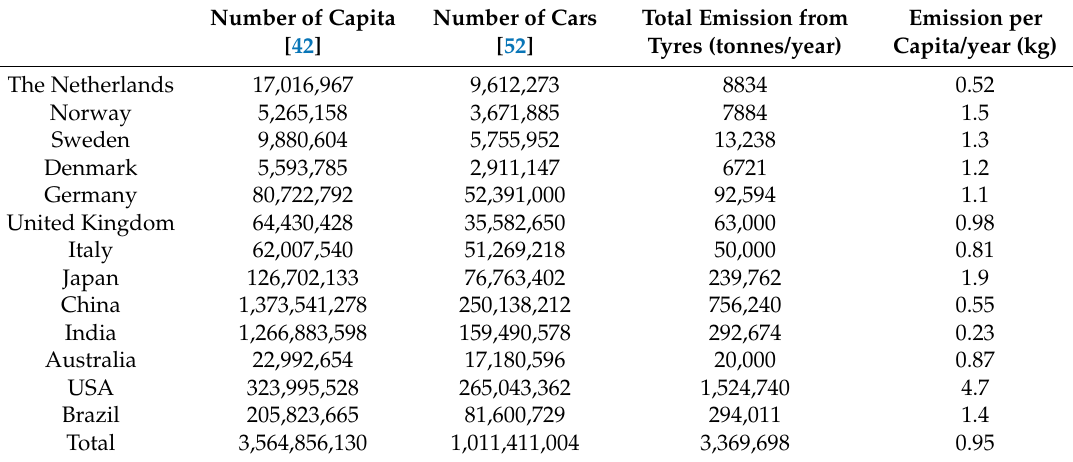
Table 13. The amount of wear and tear of car tyres per capita per year (Number of capita as per July 2016 [42], Number of cars as per 2013